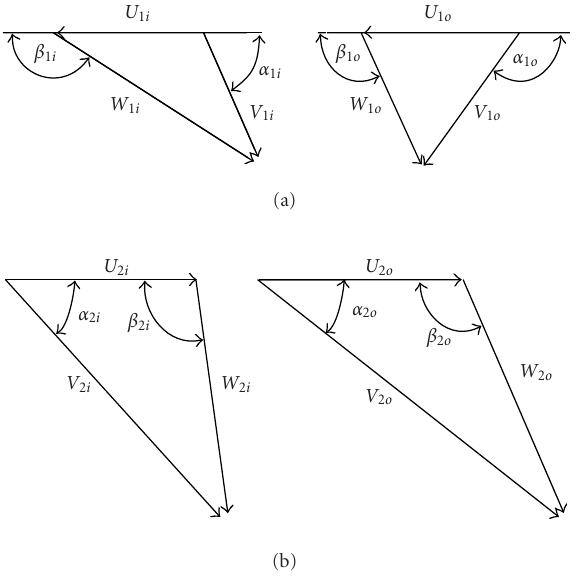
Figure 2: Velocity triangles of a cross-flow